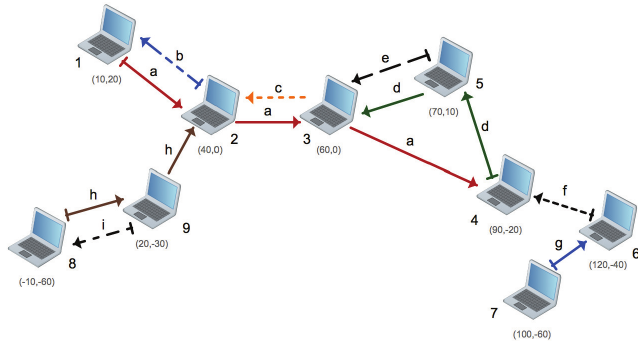
Figure 4. The multi-hop wireless ad hoc network used for simulation and numerical